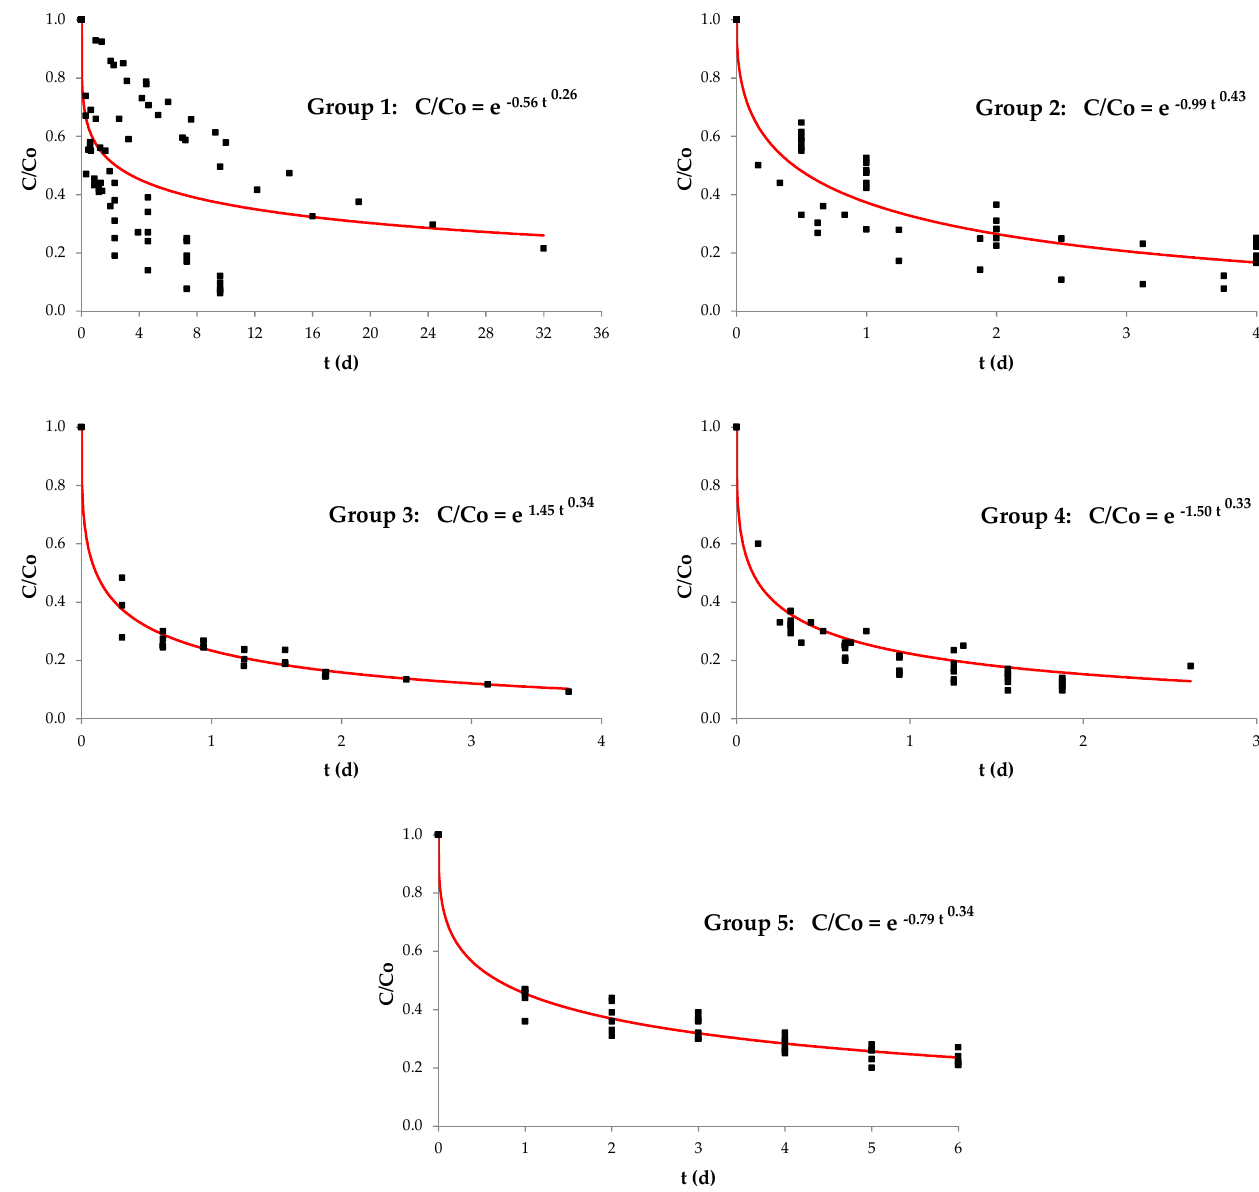
Figure 4. Common equations for sigmoidal-type model for each group.